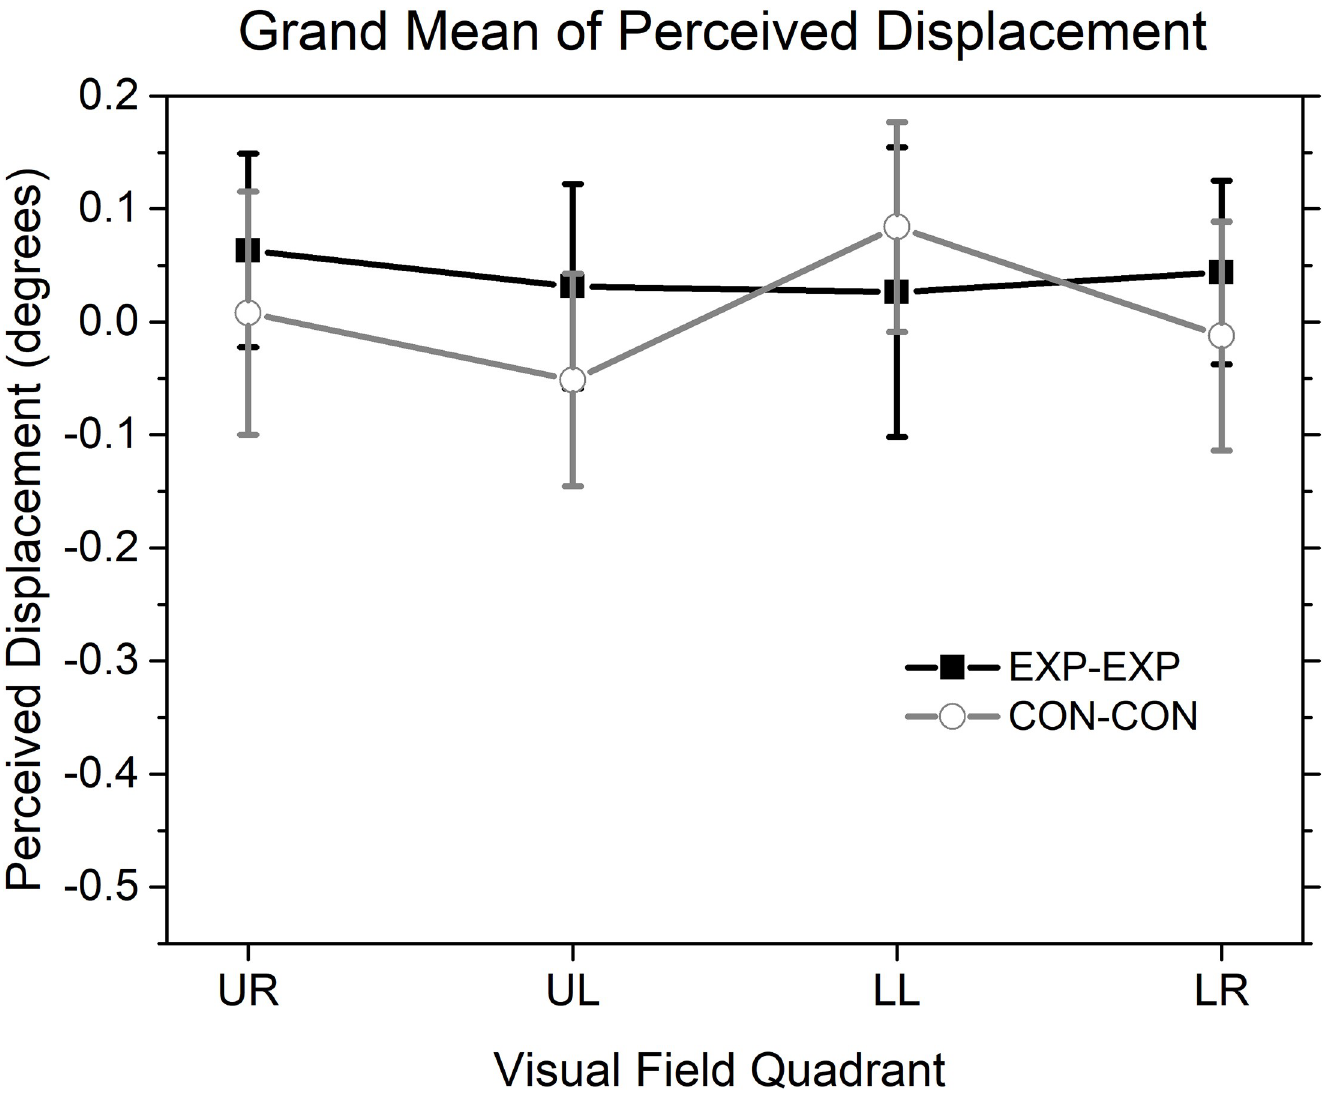
Fig 4. Mean perceived displacements between centres of flow of two patterns in each visual quadrant in the two sub-conditions (EXP-EXP and CON-CON) of Experiment 2. UR: upper right; UL: upper left; LL: lower left; LR: lower right. Vertical bars represent 95% confidence intervals. Negative values of the y-axis show that the FOE or FOC of the target pattern is perceived as closer to the fixation point than the aligned FOE or FOC of the reference pattern. The other details are as in Fig 2. the criterion for significance is 0.05/4 = 0.0125) or the CON-CON condition (p = .880, .266, .074 and .799 for the upper right, the upper left, the lower left and the lower right quadrant, respectively; Bonferroni corrected, the criterion for significance is 0.05/4 = 0.0125). Discrimination thresholds for centres of flow. Discrimination thresholds for centres of flow were also calculated for each visual quadrant in the EXP-EXP condition (the black curve in Fig 5) and the CON-CON condition (the gray curve in Fig 5). A two-way repeated measures ANOVA (Flow Direction × Quadrant) showed significant main effects of both quad- rant (F (3, 48) = 4.652, p < 0.007) and flow direction (F (1, 16) = 12.733, p < 0.004), but no sig- nificant interactions (F (3, 48) = 0.633, p = 0.597). Bonferroni corrected pairwise comparisons showed that discrimination thresholds were smaller, after averaging the data across all visual